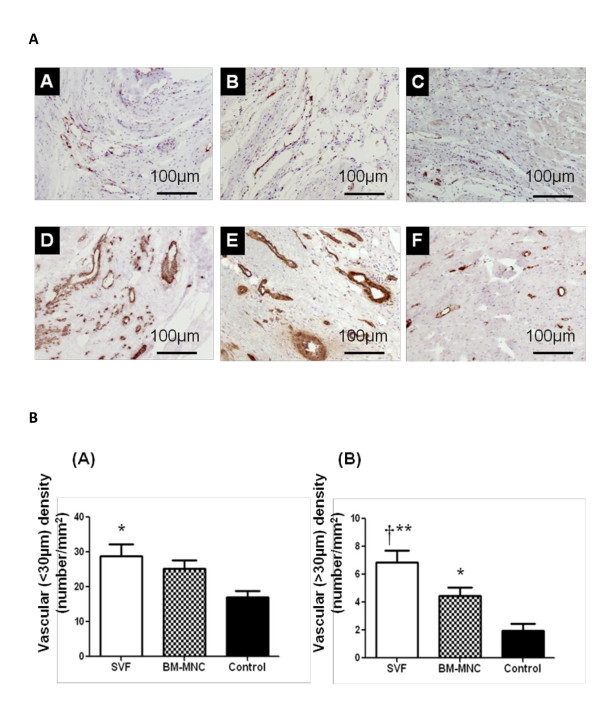
Vascular density. 2a (A-C) Immunohistochemistry for von Willebrand factor (brown, x100). Representative pictures in the peri-MI area from SVF, BM-MNC and Control groups, respectively. (D-F) Immunohistochemistry with α-smooth muscle actin antibody (brown, x100). Representative pictures in the peri-MI area from SVF, BM-MNC and Control groups, respectively. Scale bars indicate distances of 100 μm. 2b Graphs: the number of vessels (number/mm2) in the peri-MI area, micro-vessel density (density of vessels <30 μm in diameter) (A), and large-vessel density (density of vessels >30 μm in diameter) (B). Data are given as the mean ± SEM. *p < 0.05 vs. Control group, **p < 0.05 vs. BM-MNC group, †p < 0.001 vs. Control group.